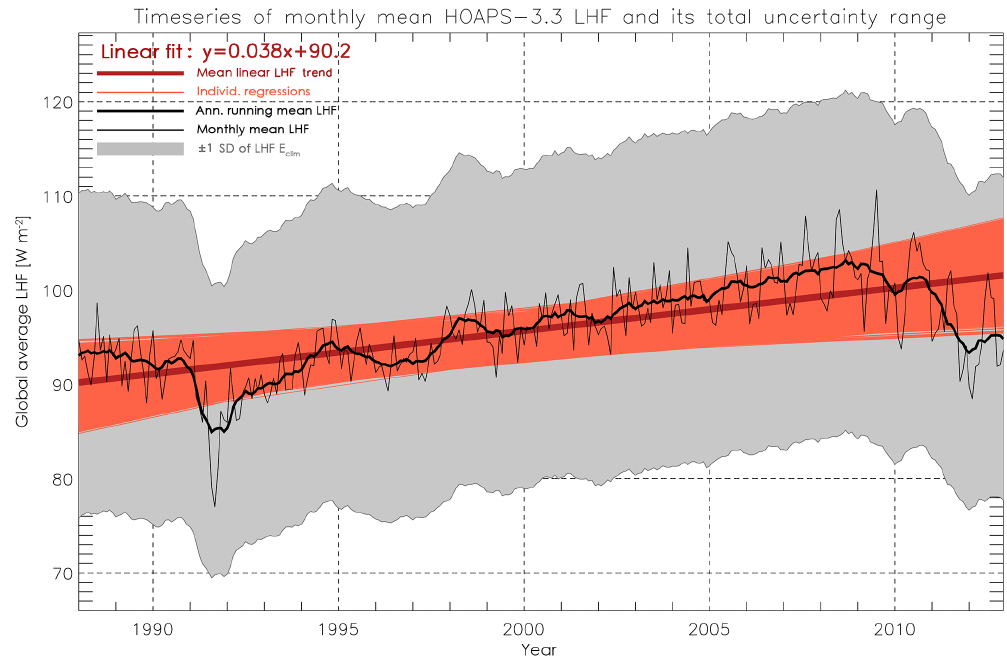
Figure 6. The thin (thick) black line shows the monthly (annual running mean) time series of HOAPS 3.3 LHF (70 ◦ S–70 ◦ N, cosine- weighted average). The dark red line illustrates the linear trend, which takes on a value of 4.5Wm − 2 per decade ( p < 0 . 00001, based on a two-tailed t test). The grey shading represents ± 1SD of the annual running mean E clim (global average). The light red regression lines were iteratively derived following Kelly (2007) by taking ± 1SD of E clim into